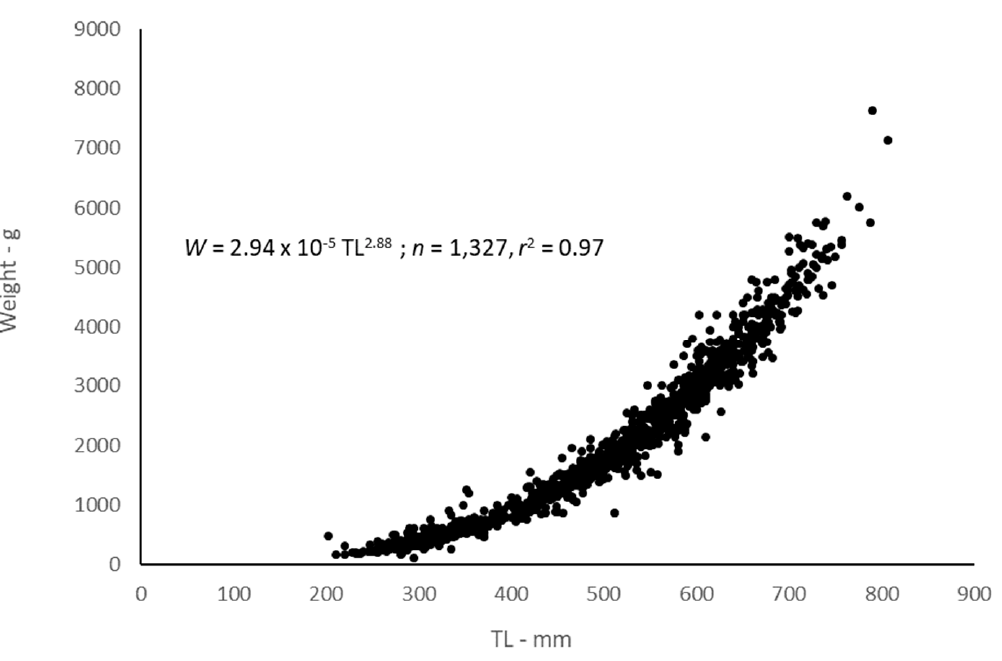
Figure 6. Weight–total-length relationship for margate, Haemulon album , for all fish measured by the Southeast Region Headboat Survey from 1979 to 2018.